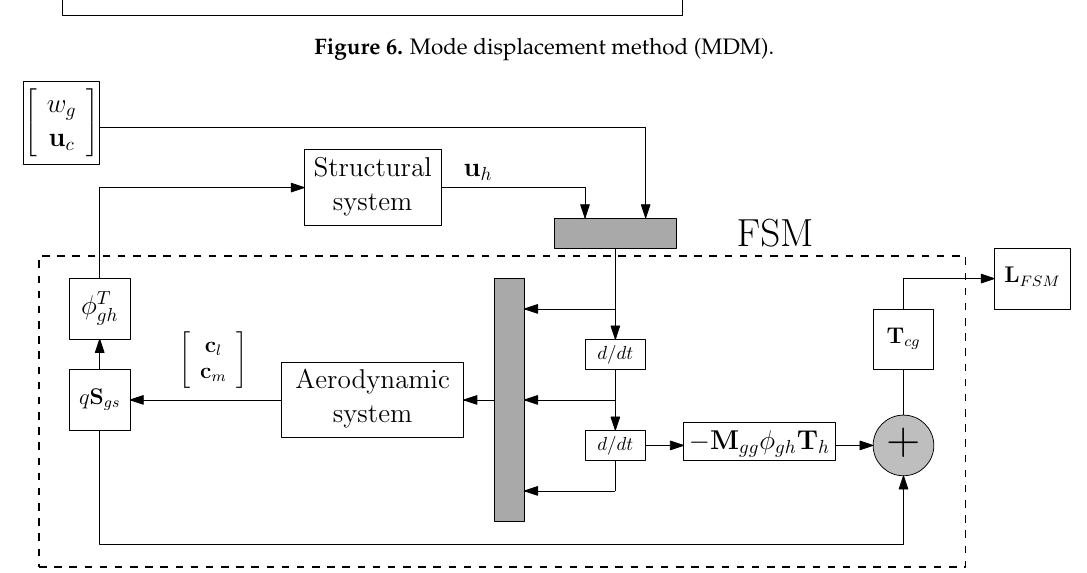
Figure 7. Force summation method